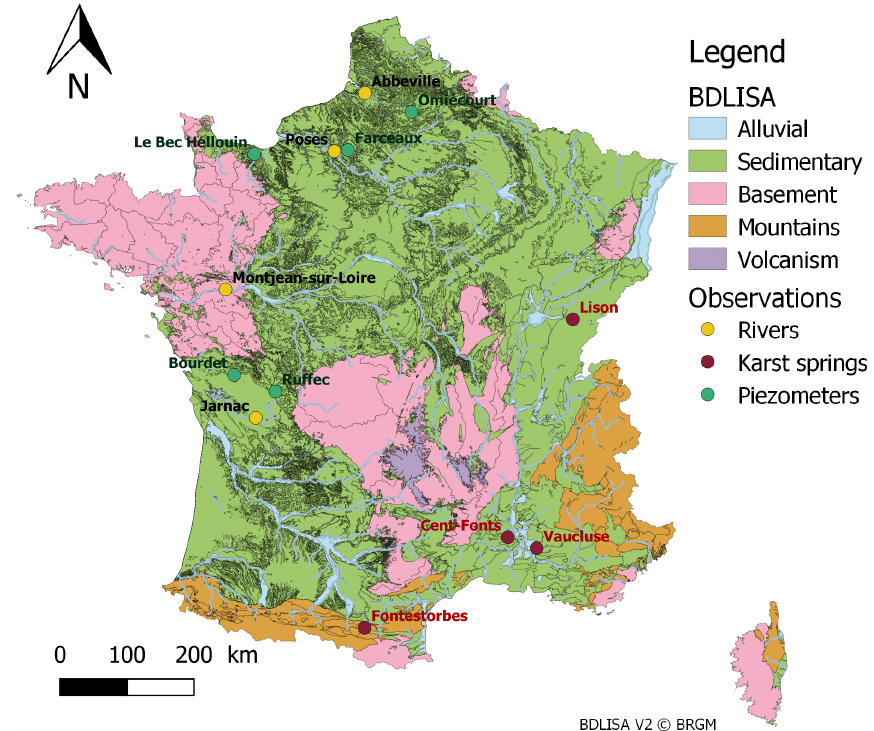
Figure 3. Main aquifers of France classified by geological type from the BDLISA version 2 database (https://bdlisa.eaufrance.fr/, last access: 11 February 2020). The names of the gauging stations and piezometers shown in Figs. 8, 12 and 13 are written. Table 1. Short description of the regional multilayer aquifer models available in AquiFR. Periods of calibration are given in the Recalibration column, and the type of variables used for recalibration are in the Variables column. GW means groundwater level, and RF is river flow. GW levels were evaluated using RMSE and bias criteria. River flows were evaluated using E f and the ratio criteria. Software Model Number Number Recalibration of layers of